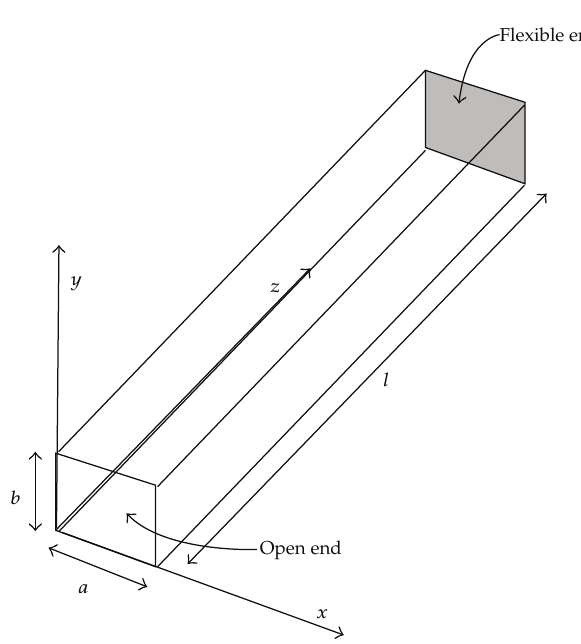
Figure 1: The rectangular tube with one open end, one flexible end, and four rigid side walls.